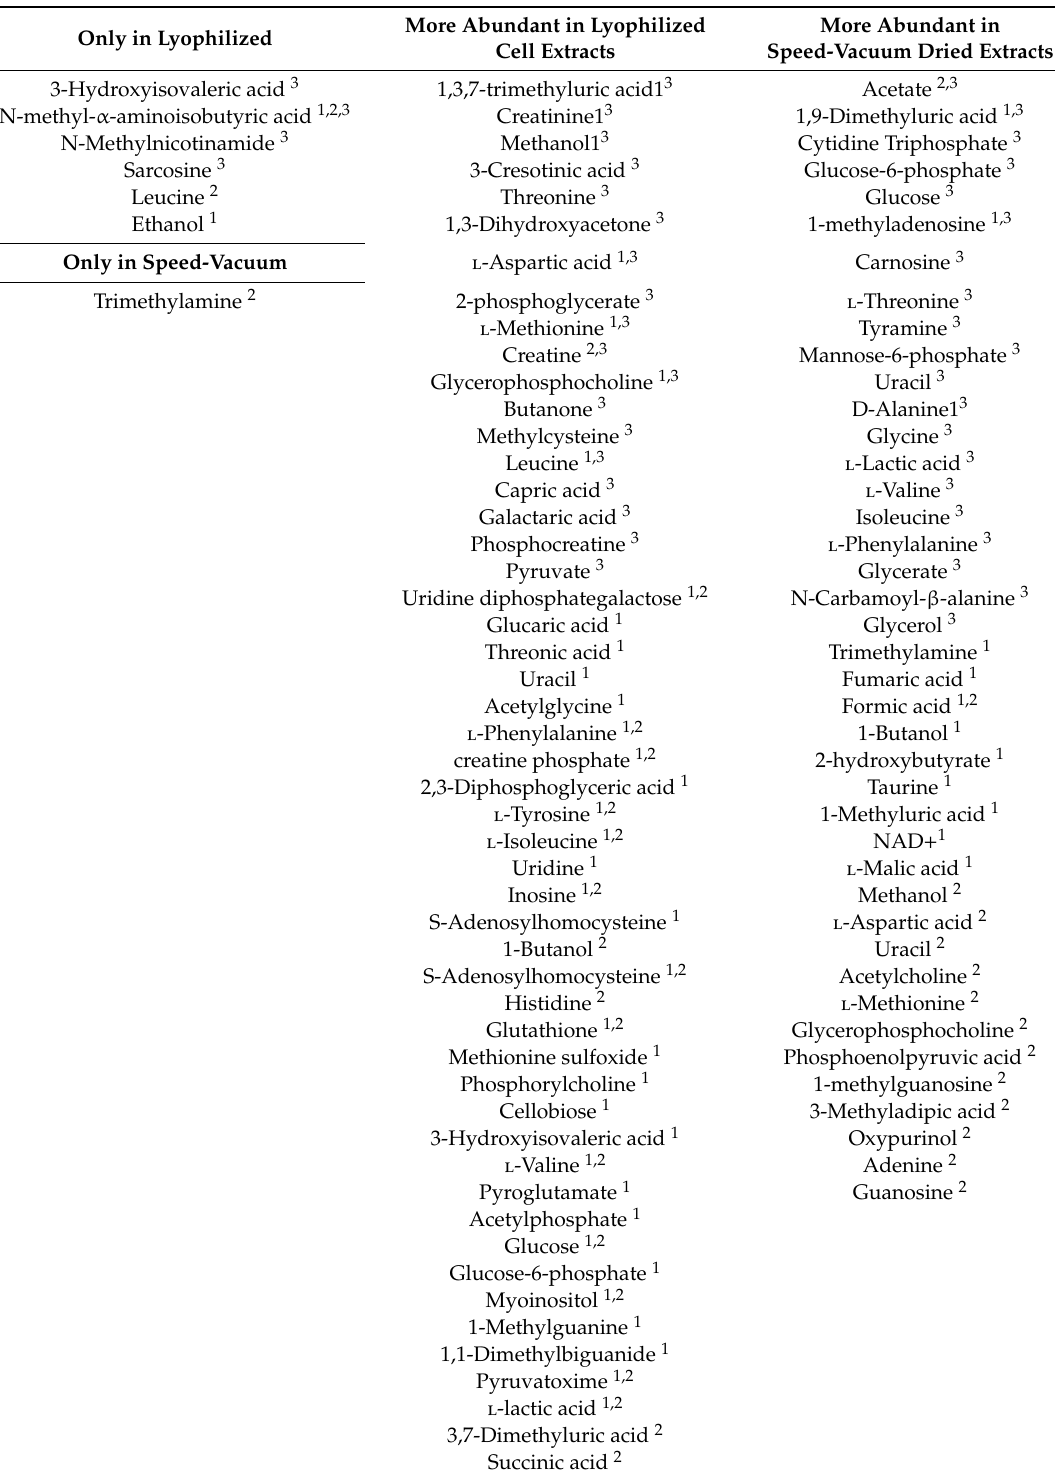
Table 1. Summary of metabolite di ff erences in resuspended MiaPaCa-2, Panc-1 and AsPC-1 cell extract samples depending on the drying method used for sample